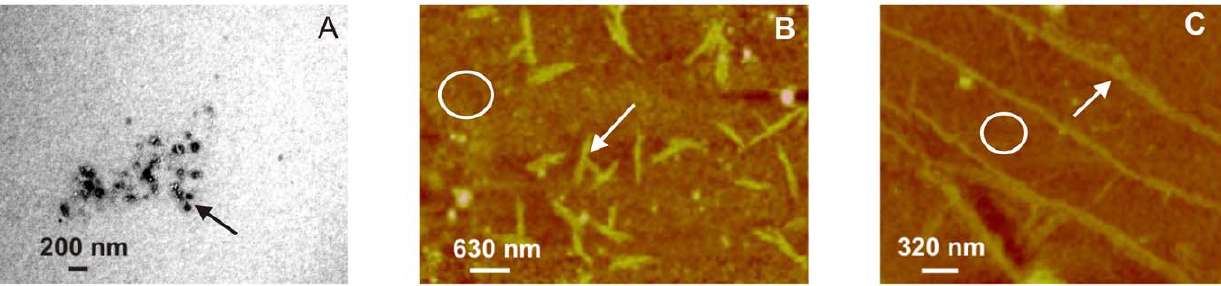
Figure 8. Morphology of HClO-induced apoA-I aggregates. Panels illustrate representative images of apoA-I samples studied by transmission Electron Microscopy (A) and Atomic Force Microscopy (B,C) A) Protein was incubated at 0.2 mg/mL for 24 h and 37 u C at 100 m M HClO. Black arrow shows representative aggregates. B and C) ApoA-I (0.6 mg/mL) for 24 h and 37 u C at 100 m M HClO, and loaded stepwise onto the mica. Small size oligomers covering the surface of the mica (represented by the white circle), plus some short (B) and long (C) thin protofibers (white arrows) could be observed. Scale bars are shown in each panel.